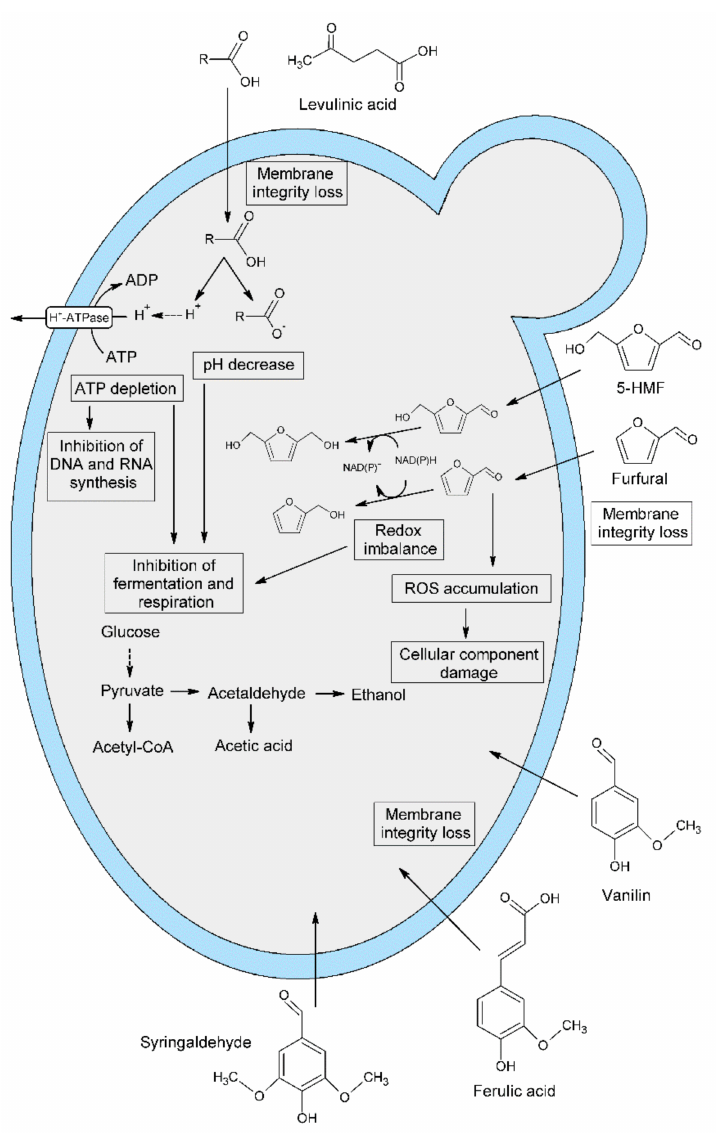
Figure 1. Effect of lignocellulose pretreatment by-products on yeast cell metabolism. The inhibitory effect may be due to the presence of volatile fatty acids (VFAs) such